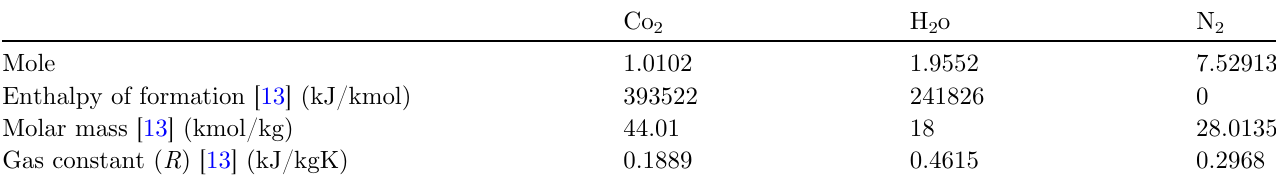
Table 2. The fl ue gas